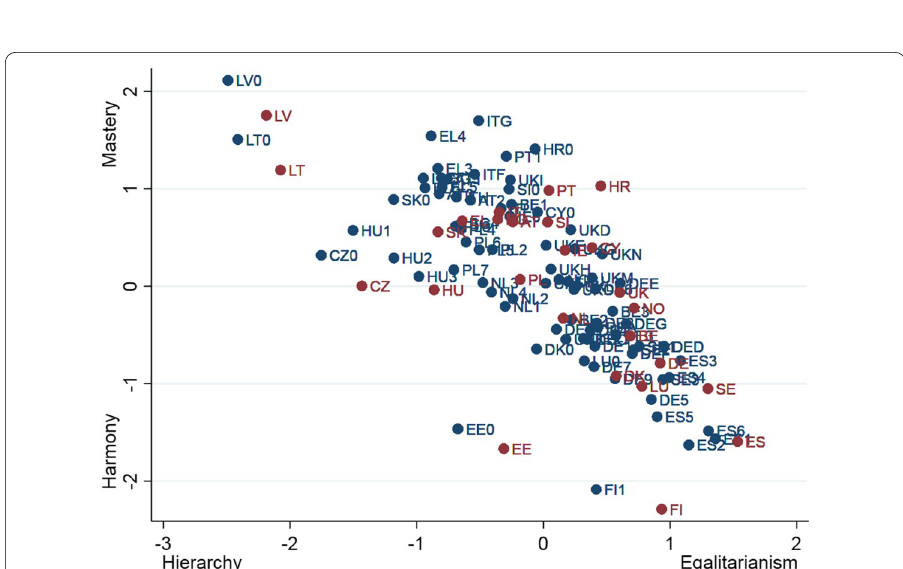
Fig. 2 Scatterplot of mastery–harmony and egalitarianism–hierarchy